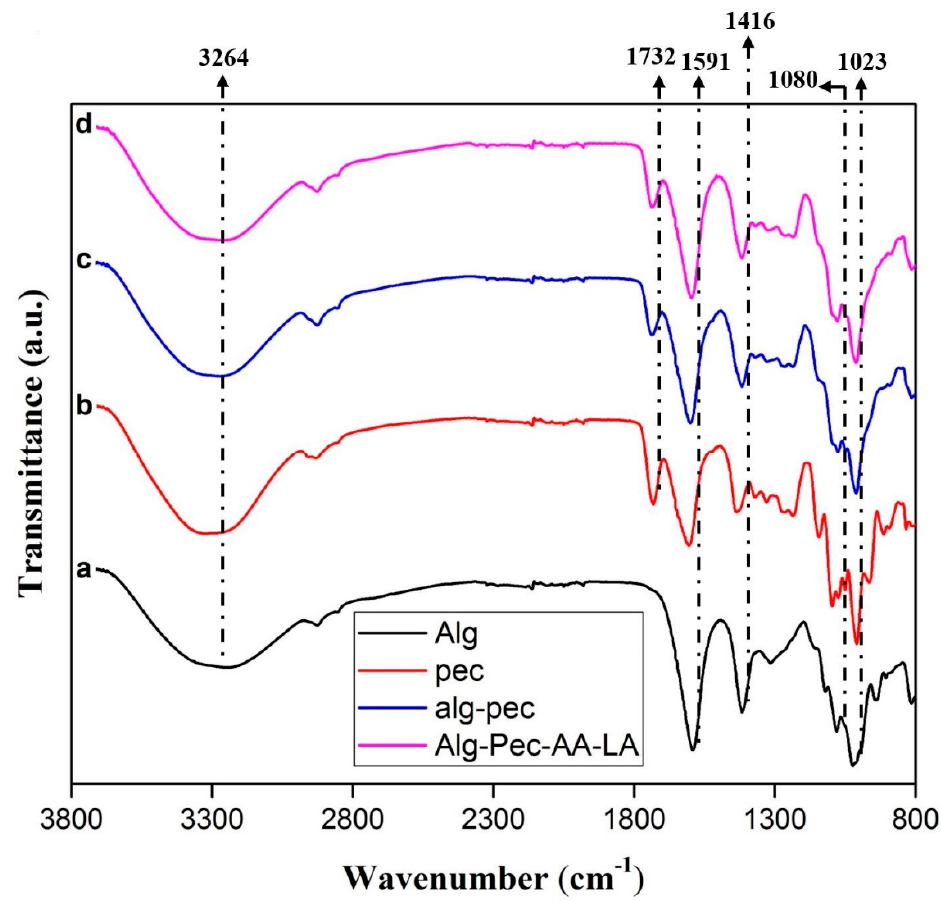
Figure 5. FT-IR spectra of crosslinked ( a ) alginate, ( b ) pectin, ( c ) Alg–Pec, and ( d ) Alg–Pec–AA–LA films. Table 2. FTIR-ATR main vibrational frequencies of pectin–alginate based films.